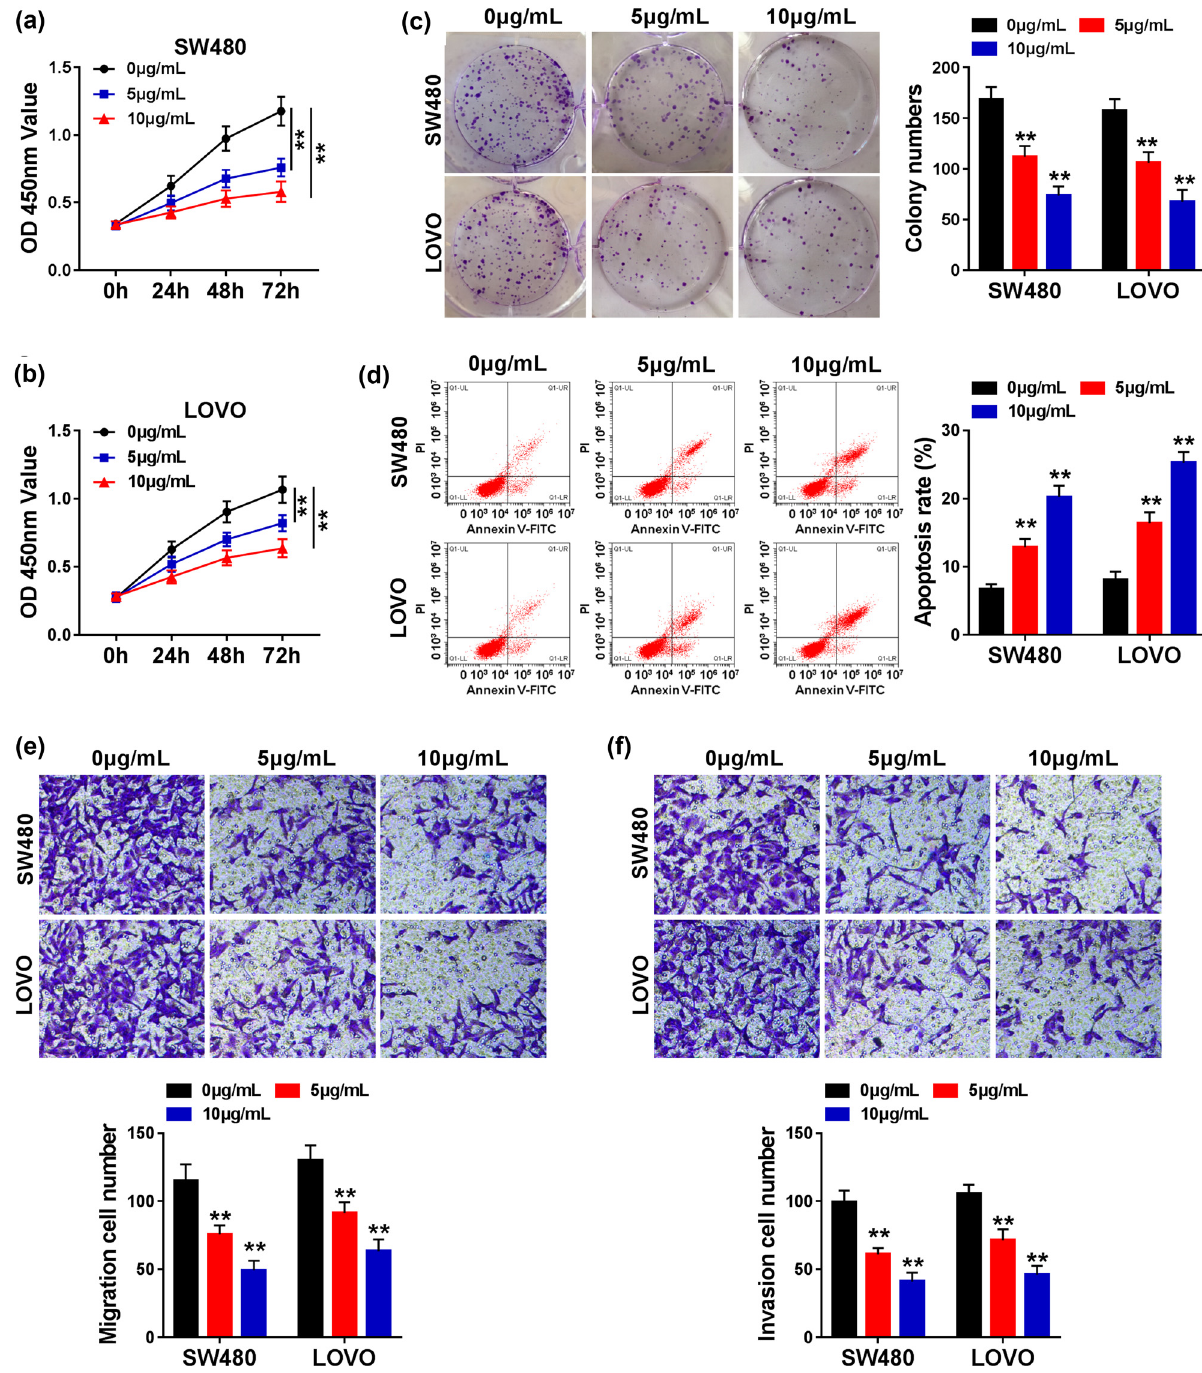
Figure 1: Propofol repressed cell proliferation, migration, and invasion, whereas induced cell apoptosis in SW480 and LOVO cells. SW480 and LOVO cells were treated with various doses of propofol ( 0, 5, and 10 μ g/mL ) . ( a – c ) Cell proliferation was determined by CCK8 and colony formation assays. ( d ) Cell apoptosis was demonstrated by fl ow cytometry assay. ( e and f ) Cell migration and invasion were detected by transwell assay. Signi fi cant di ff erences were compared with ANOVA. ** P <